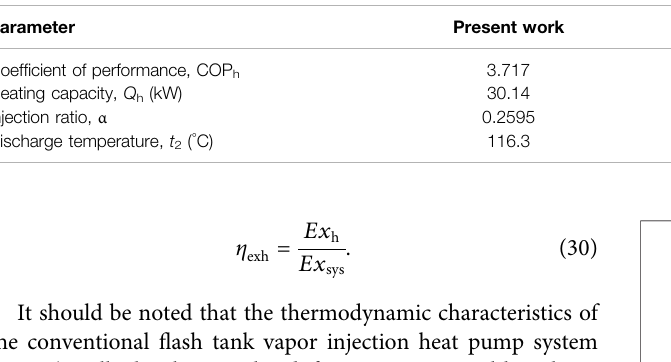
TABLE 2 | Validation of the FVHP system model with the existing work.